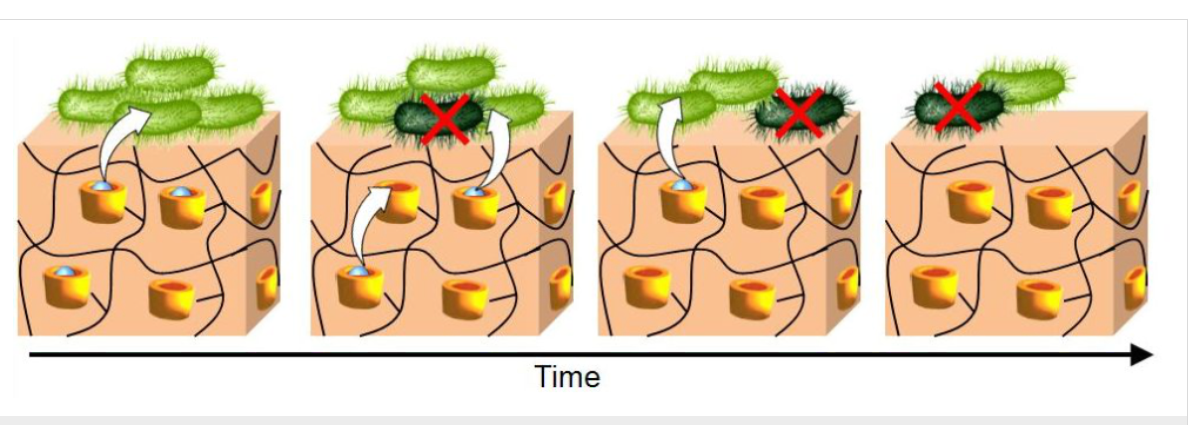
Scheme 8: Schematic representation of biocide release from a chemically cross-linked CD